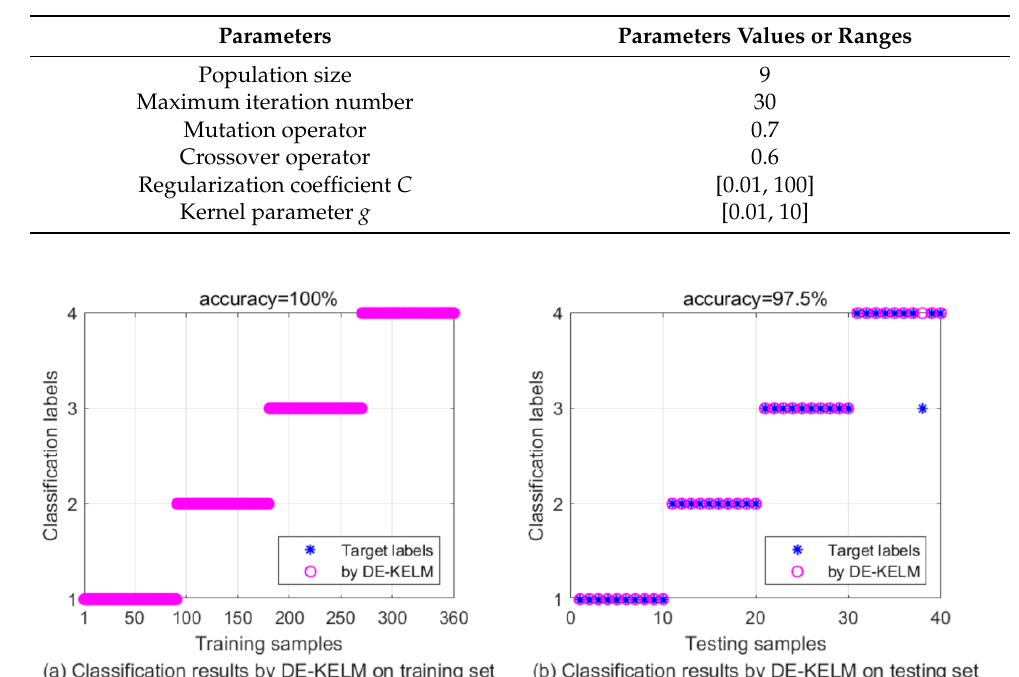
Table 6. Parameter configuration of DE.